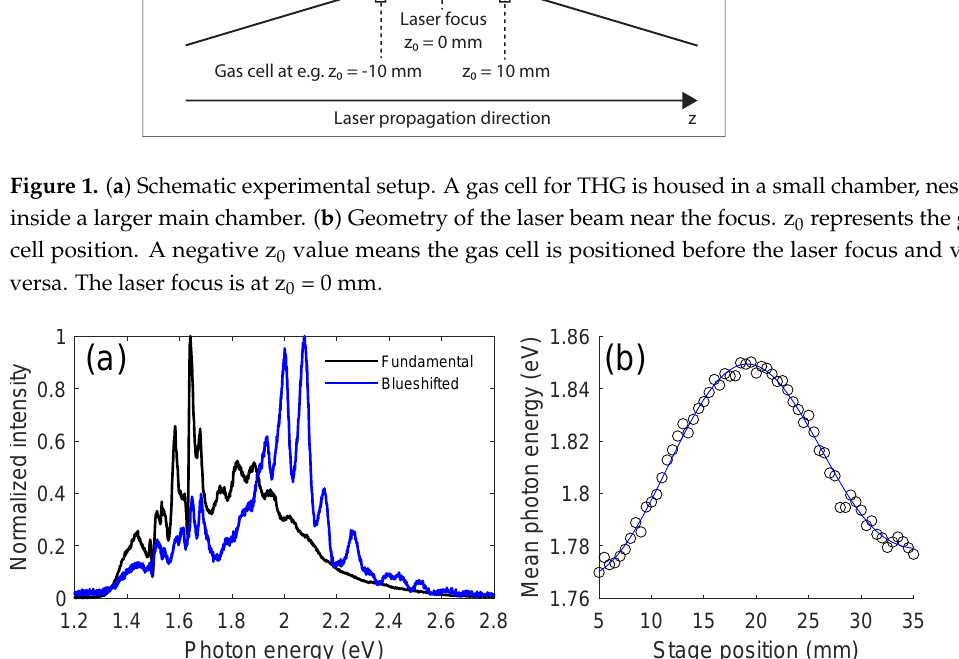
Figure 2. ( a ) Spectra of the NIR laser before and after transmission through the gas cell, measured when the gas cell was positioned at the tightest focus position. The transmitted NIR spectrum was blue-shifted (higher photon energy). ( b ) Mean photon energies of the transmitted NIR laser as a function of the cell position. The amount of blue-shift was used to determine the best focus position z 0 = 0 mm, which is 18.25 mm in ( b